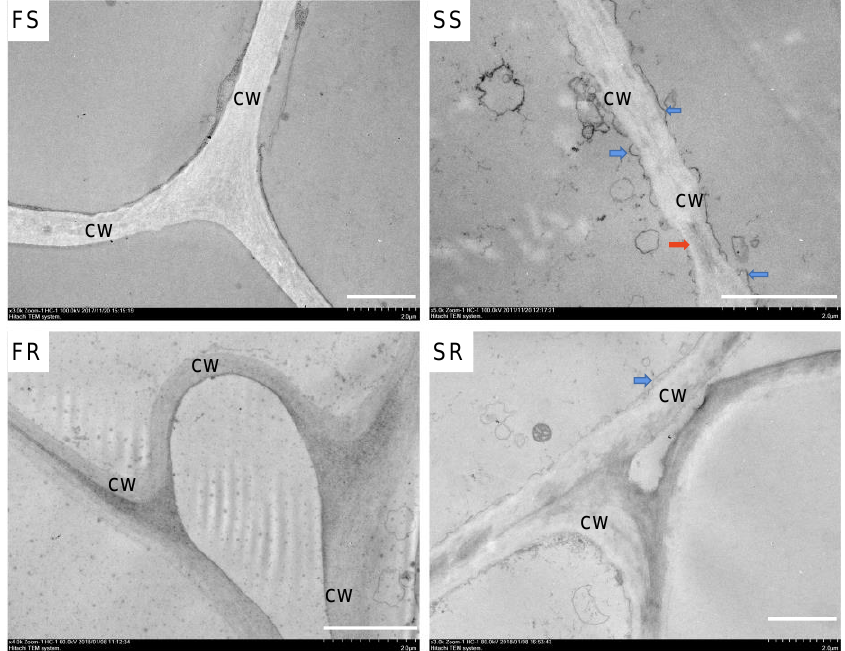
Figure 2. Transmission electron microscopy images of SC8 and RYG1 cassava. CW, cell wall. Blue arrow, plasma membrane invagination. Red arrow, cell wall collapse. The white lines indicate 2 μm.